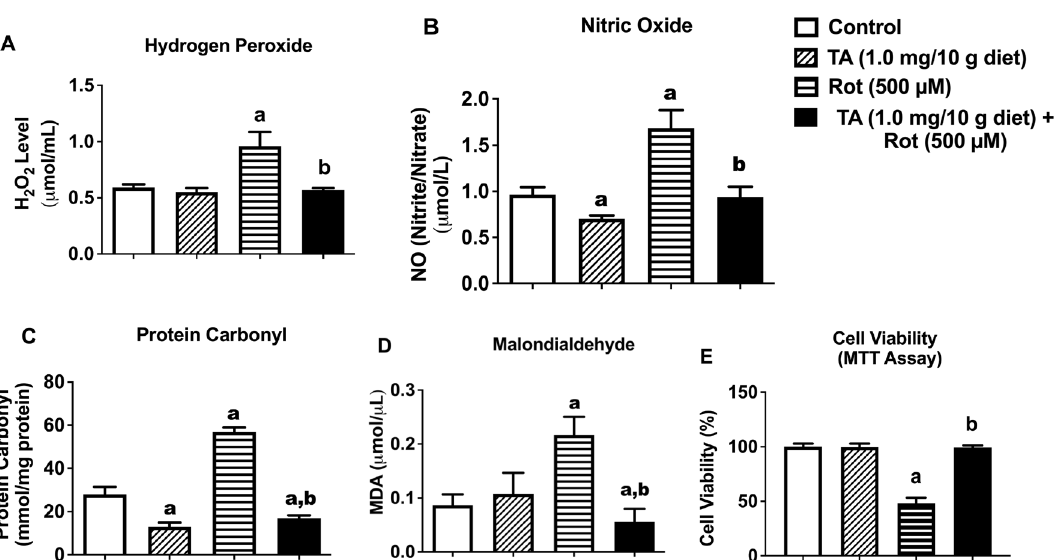
Figure 3. Effects of TA (1.0 mg/10 g diet) and/or rotenone (500 μM) on H 2 O 2 ( A ), NO ( B ), Protein Carbonyl ( C ), Malondialdehyde ( D ), and Cell Viability (MTT assay) ( E ). Data in ( A – E ) are presented as Mean ± SEM of 50 flies per vial (five replicates per group). a: Significant difference compared with control group; b: Significant difference compared with rotenone group (p < 0.05). TA trans-astaxanthin, H 2 O 2 hydrogen Rotenone exposure impairs survival rate and alters antioxidative status and inflammatory marker in D. melanogaster . Rotenone significantly reduced survival rate of D. melanogaster after 30 days of treatment compared with the control (Fig. 2A, p < 0.05). Additionally, rotenone significantly reduced NPSHs (Fig. 2B) and T-SHs (Fig. 2C) and elevated H 2 O 2 (Fig. 2D) and NO (Fig. 2E) levels compared with the control. Apart from this, rotenone inhibited activities of GST (Fig. 2F) and Catalase (Fig. 2G) compared with the control flies (p < 0.05). Consequently, 500 μM dose of rotenone was selected in the ameliorative study with TA. TA attenuates rotenone‑induced increased levels of oxidative stress and inflammatory mark‑ ers, and reduced cell viability in D. melanogaster . TA restored to normal, rotenone-induced elevation of H 2 O 2 (Fig. 3A), nitric oxide (Fig. 3B, nitrite/nitrate), and blocked the increase of protein carbonyl (Fig. 3C),